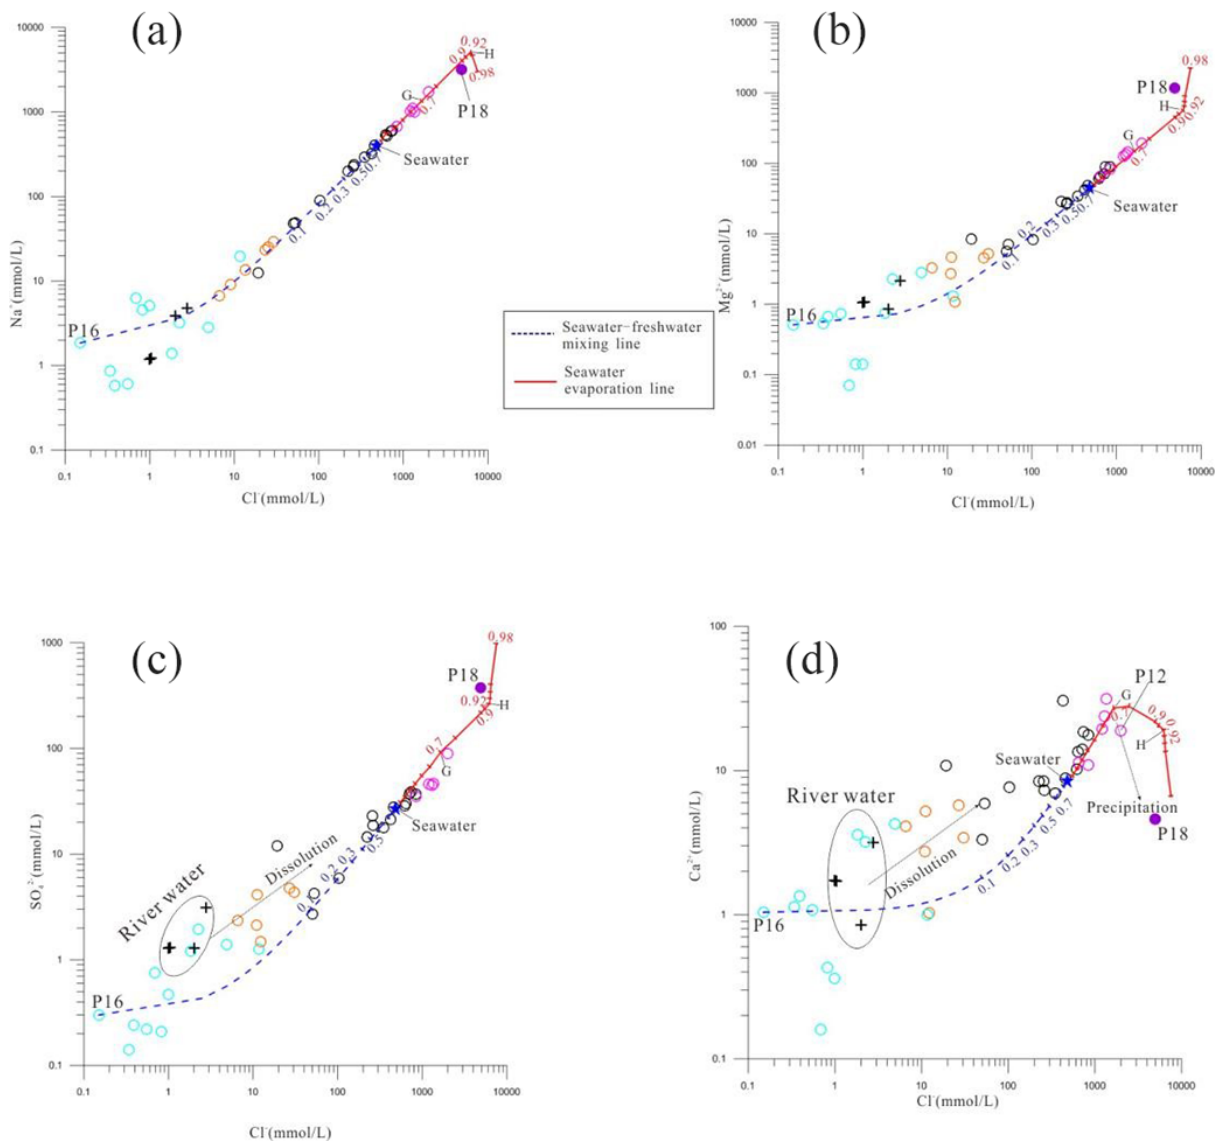
Figure 6. Hydrochemical relationships between Cl and major ions of the measured samples and simulated results in groundwater. Seawater– freshwater mixing line: theoretical mixing between seawater and deep fresh groundwater. Blue numbers: mixing ratios of seawater. Seawater evaporation line: theoretical evaporation of Bohai seawater. Red numbers: evaporation rates. G: precipitation of gypsum. H: precipitation of halite. Dissolution: possible gypsum dissolution along with river water recharging. The symbols used for the samples are the same as